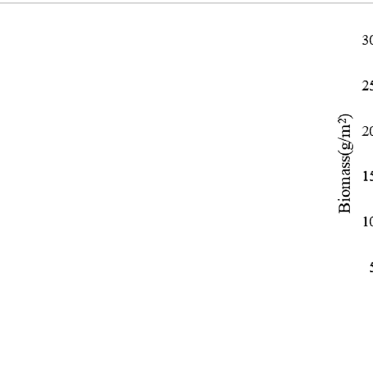
FIGURE 3 Aboveground biomass of grassland plants with different years of arti fi cial afforestation in the Maxian Mountains of the Loess Plateau. Different lowercase letters indicate statistically signi fi cant differences in aboveground biomass of grassland plants between arti fi cial afforestation years by LSD test (p< 0.05).